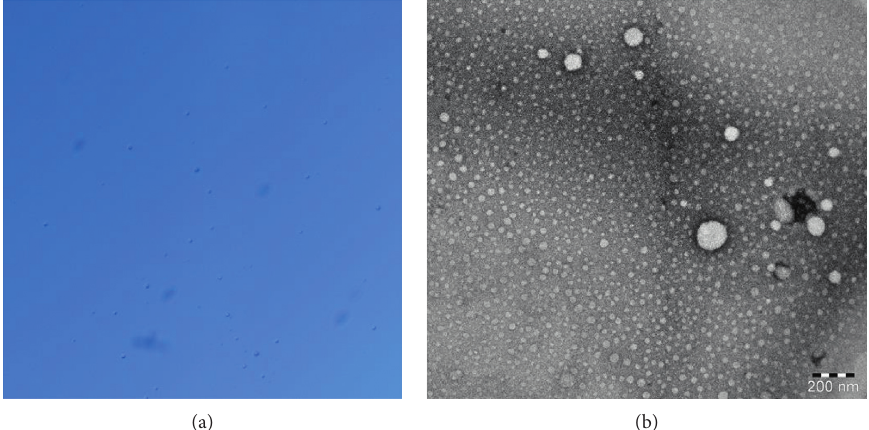
Figure 3: Presentation on morphology of the optimized formulation under the polarized microscope (a) and transmission electron microscope (b).